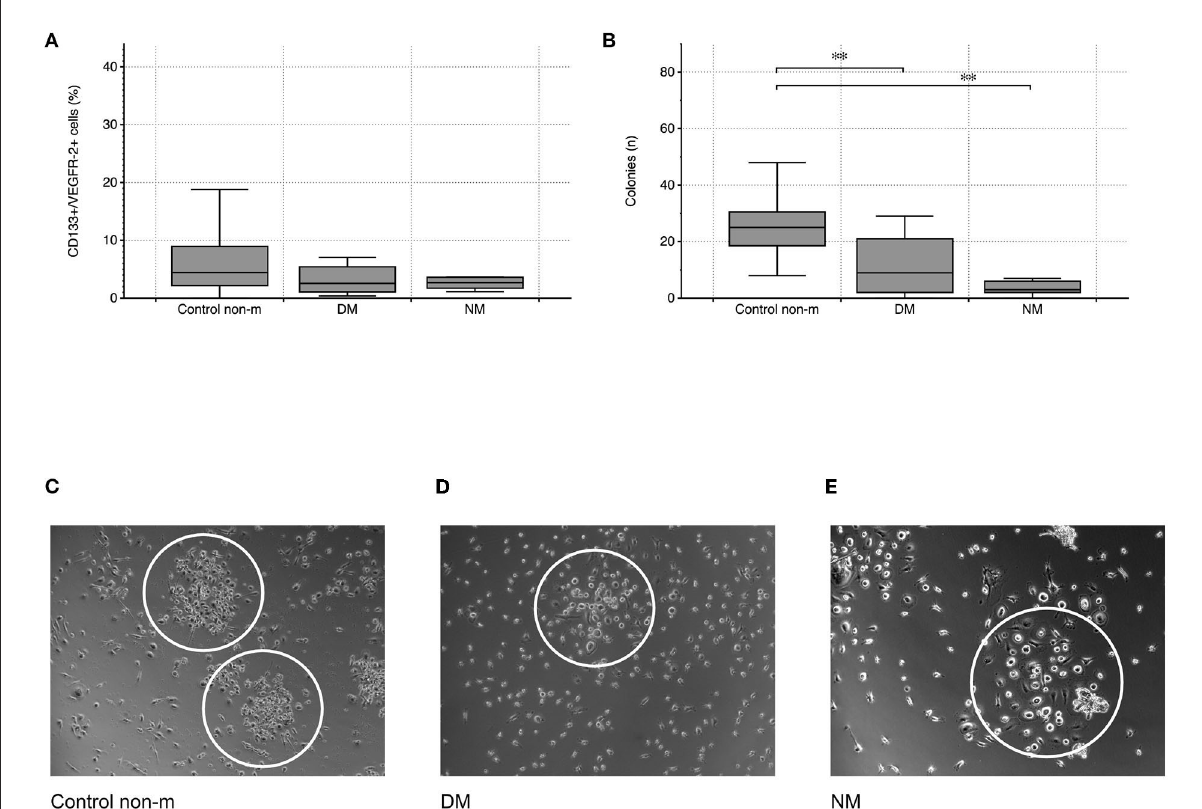
FIGURE1 Cytometric quantification of peripheral circulating eEPCs (CD133 + /VEGFR-2 + cells) indicated lower percentages in the DM group without reaching the level of significance (A). Blood-derived eEPC colonies were significantly lower in the two disease groups (B). Images (C–E) depict representative patterns of colony formation in controls and in the disease groups (DM and NM). The white ovals surround individual colonies. The following numbers of samples were analyzed per group: Control non-m: n = 40; DM: n = 15; NM: n = 6 (Control non-m: non-myopathic control; magnifications: × 20 in Control non-m and in DM; × 40 in NM; * , p-value < 0.05; ** , p-value <